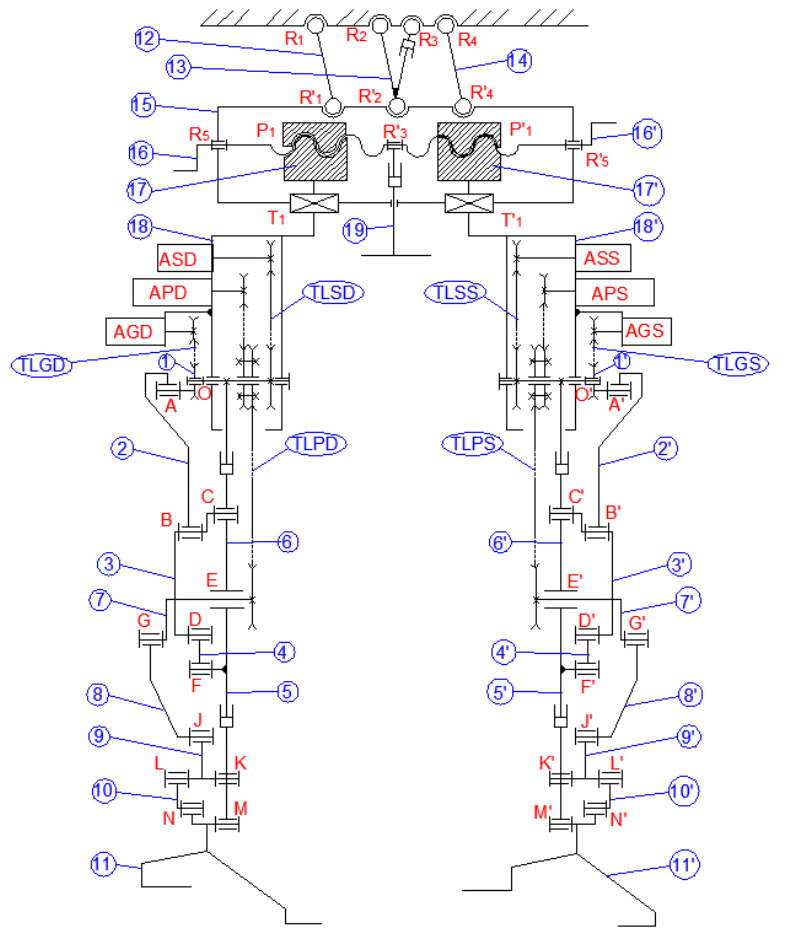
Figure 7. Exoskeleton structural scheme.